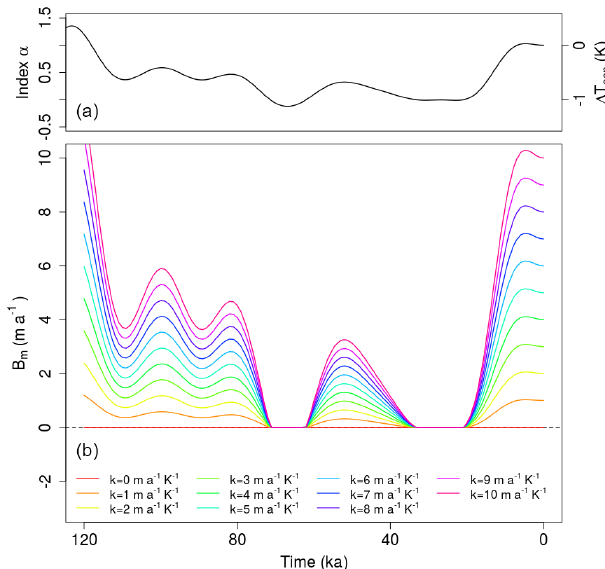
Figure 1. Evolution of the climatic index α and the resulting past oceanic temperature anomaly (cid:49)T ocn (K) (a) . Potential submarine melt-rate evolution during the last glacial period for increasing B ref and κ values considered in the experiments (b) .